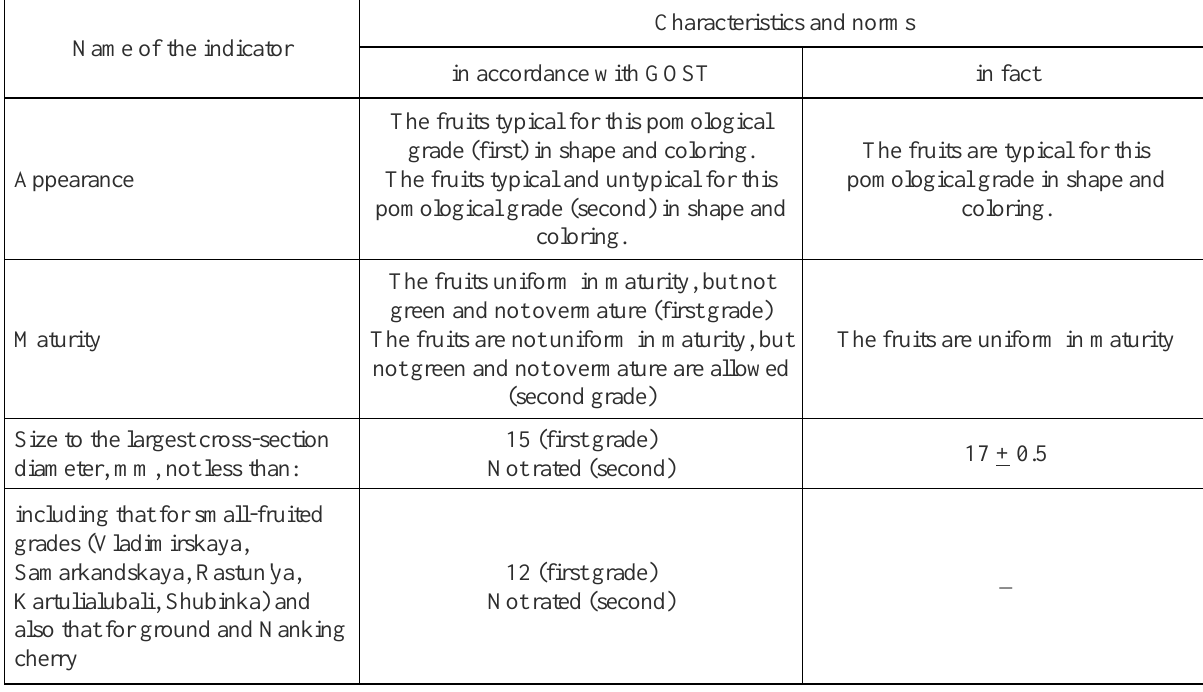
Table 9. Indicators of quality of Prunus fruticosa (ground cherry, the grade “Altayskaya lastochka”), n = 5